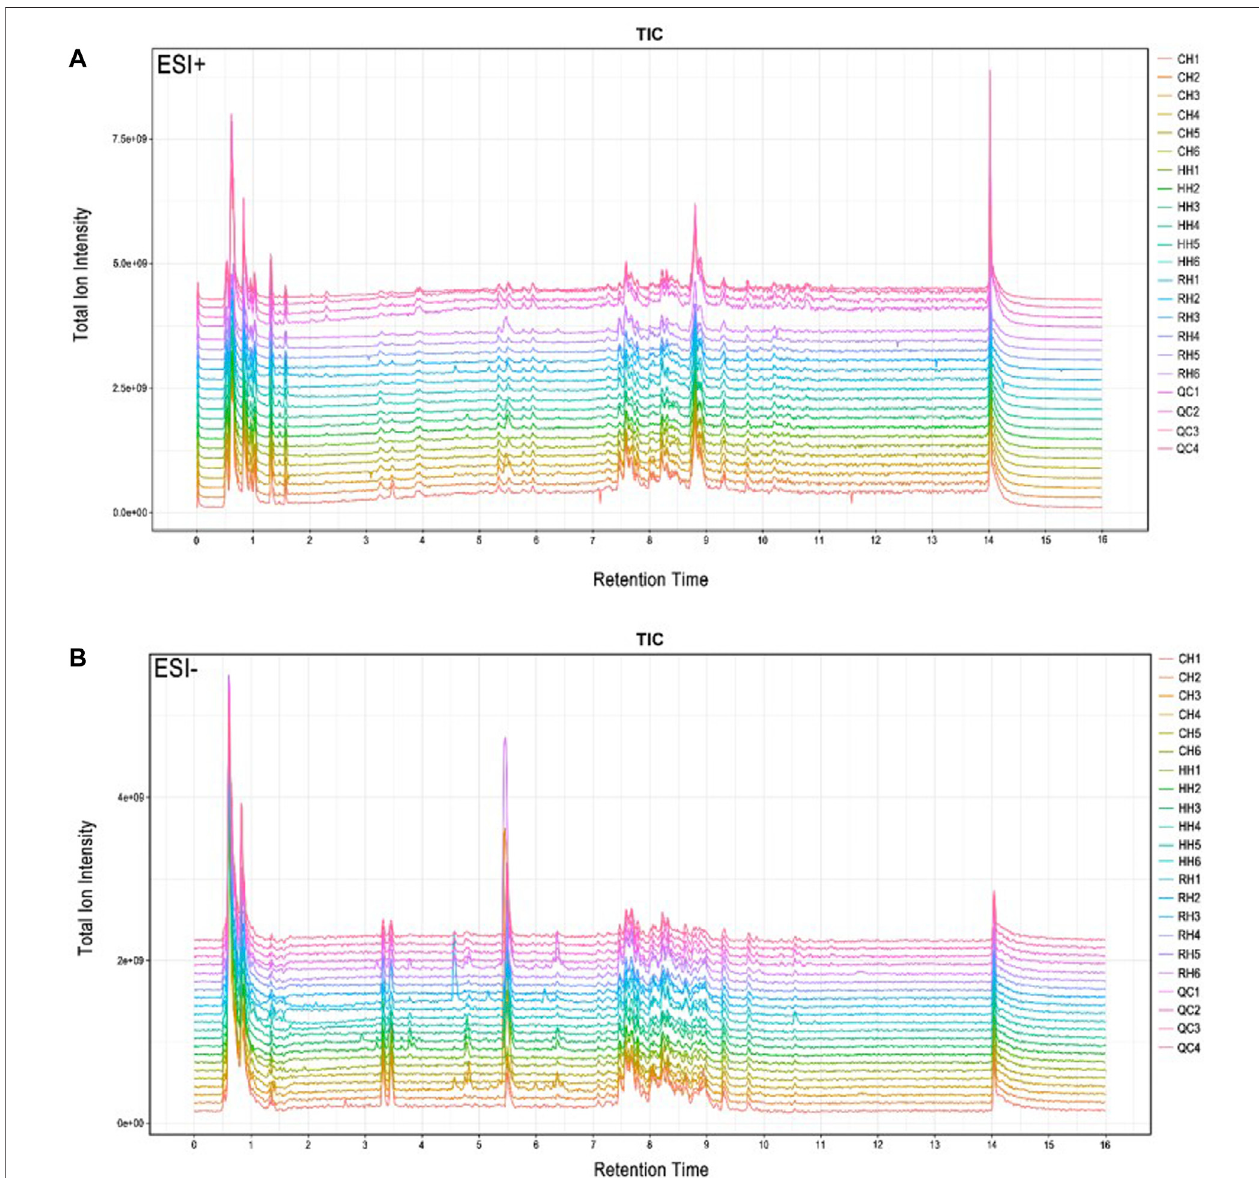
FIGURE 1 | Total ion fl ow (TIC) of the samples of hepatopancreas of Cyprinus carpio var. qingtianensis were obtained in the modes of positive (ESI + ) and negative (ESI-). Note: (A) : ESI + mode; (B) : ESI - mode; CH1-CH6: normoxic group with 6 samples; HH1-HH6:6 samples from the experimental group under hypoxic stress for 6 h; RH1-RH6: Reoxygenation recovery with 6 h experiment and 6 samples; QC1-QC4: Quality control with 4 samples.